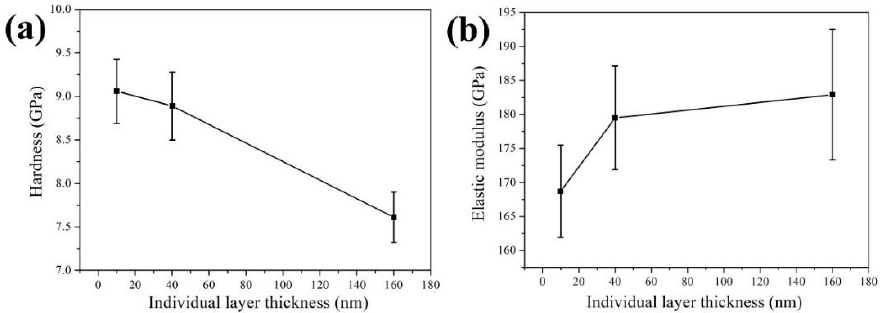
Figure 7. ( a ) The hardness and ( b ) the elastic modulus measured by nano-indentation of Ni/Ni 3 Al- MoW multilayers plotted as a function of h .